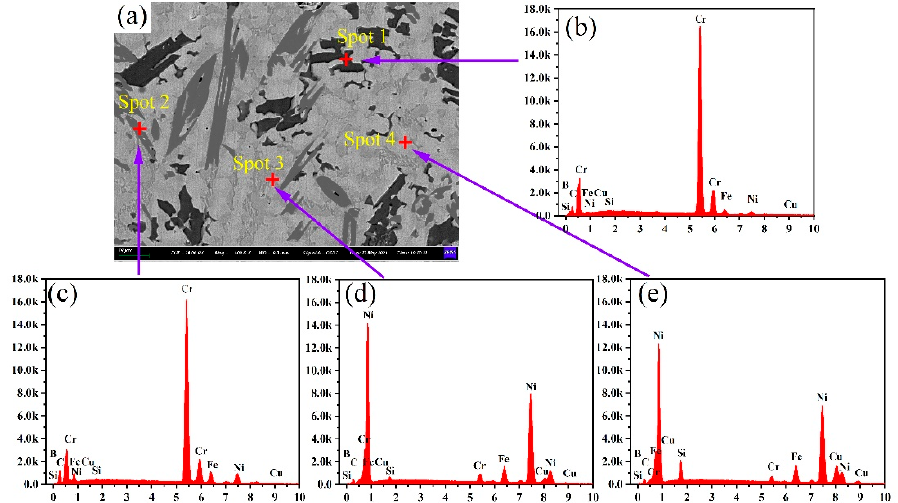
Figure 6. SEM micrograph and EDS analysis of Ni60A coating: ( a ) the magnified SEM micrograph of the area marked by a small rectangle in Figure 5c, ( b – e ) the EDS analysis results of spots 1–4. Table 3. EDS spot analysis results of each point marked in Figure 6 (at.%).